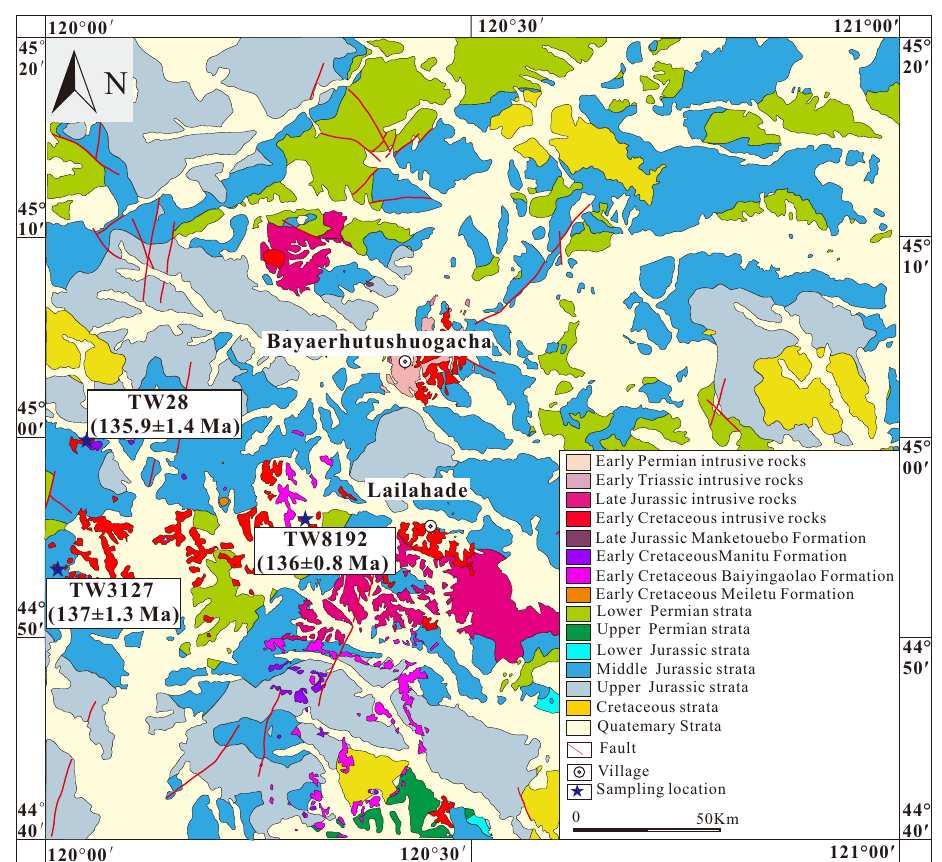
Figure 2. Simplified geological map of the Zalute area in the